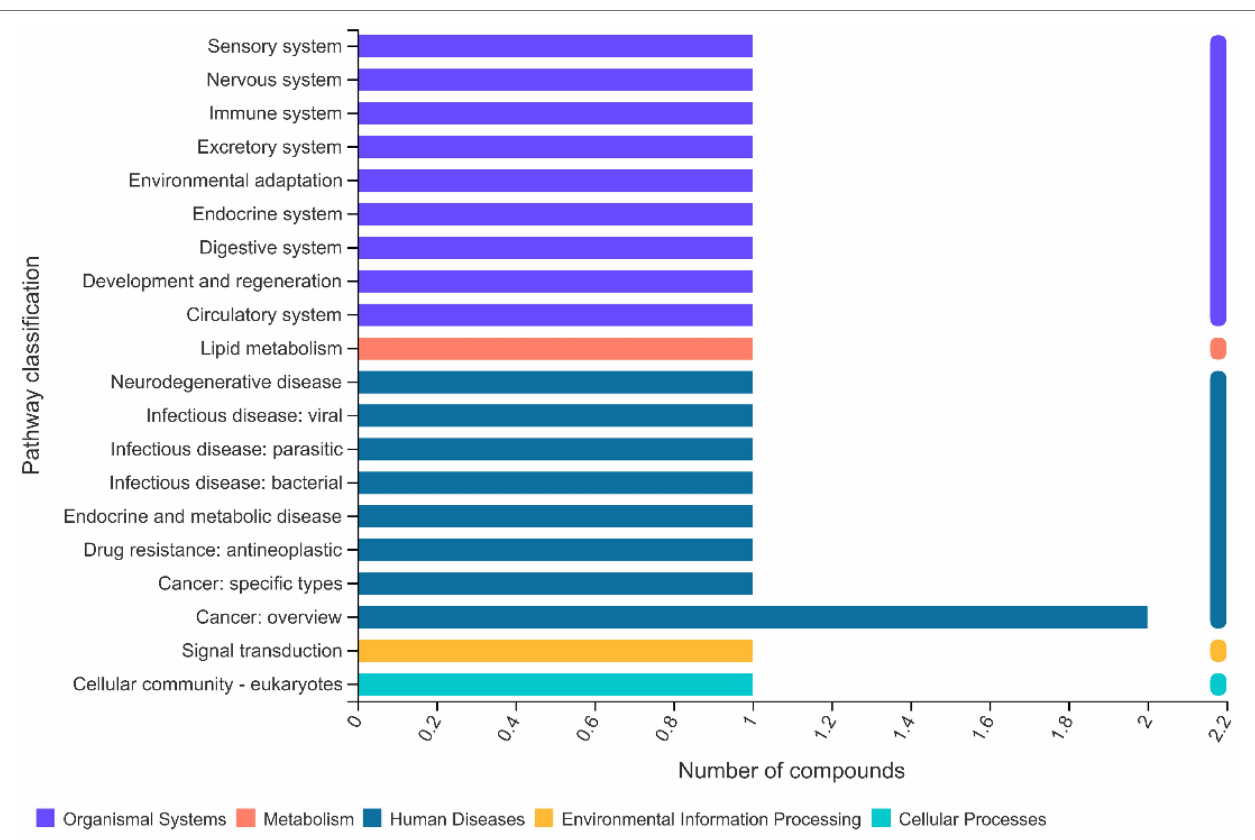
FIGURE 11 | Effects of methionine restriction on the KEGG pathways of lipidomics data after feeding for 8 weeks ( n =